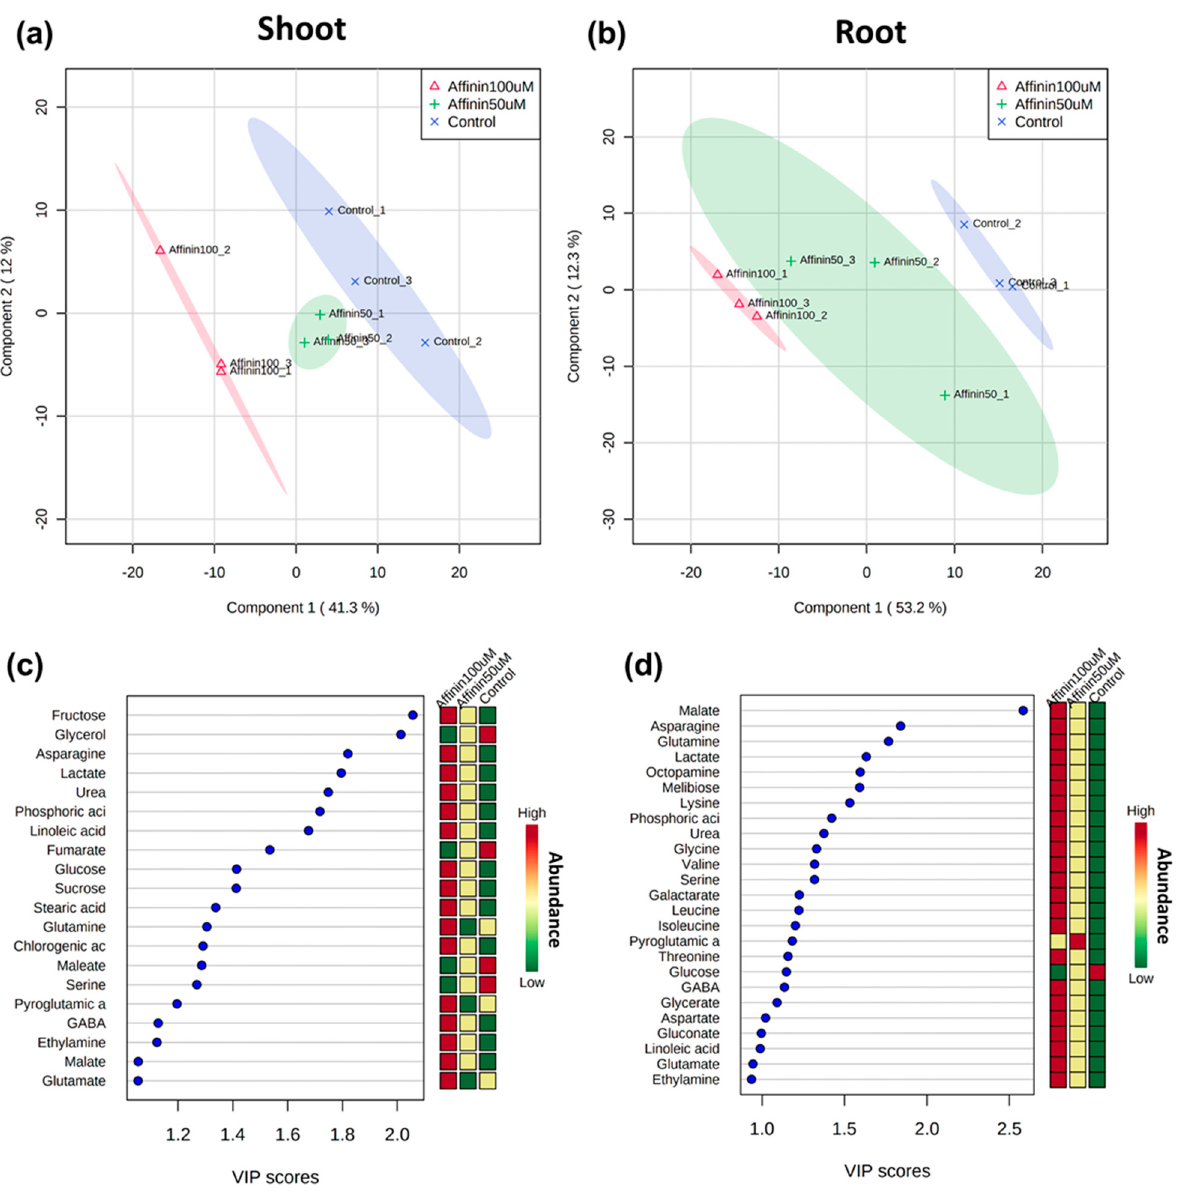
Figure 4. Score scatter plots of the two-component PLS-DA model based on the relative level of identified metabolites among samples from: ( a ) shoots R 2 = 0.99, Q 2 = 0.63; and roots ( b ) R 2 = 0.96, Q 2 = 0.79. The discrimination between affinin treatments for most important metabolites (VIP scores) responsible for the separation of clusters in PLS-DA, with the mini-heatmap on the right of each graph indicating their variation in concentration within different treatments for: shoots ( c ) and roots ( d ) ( n = 3).